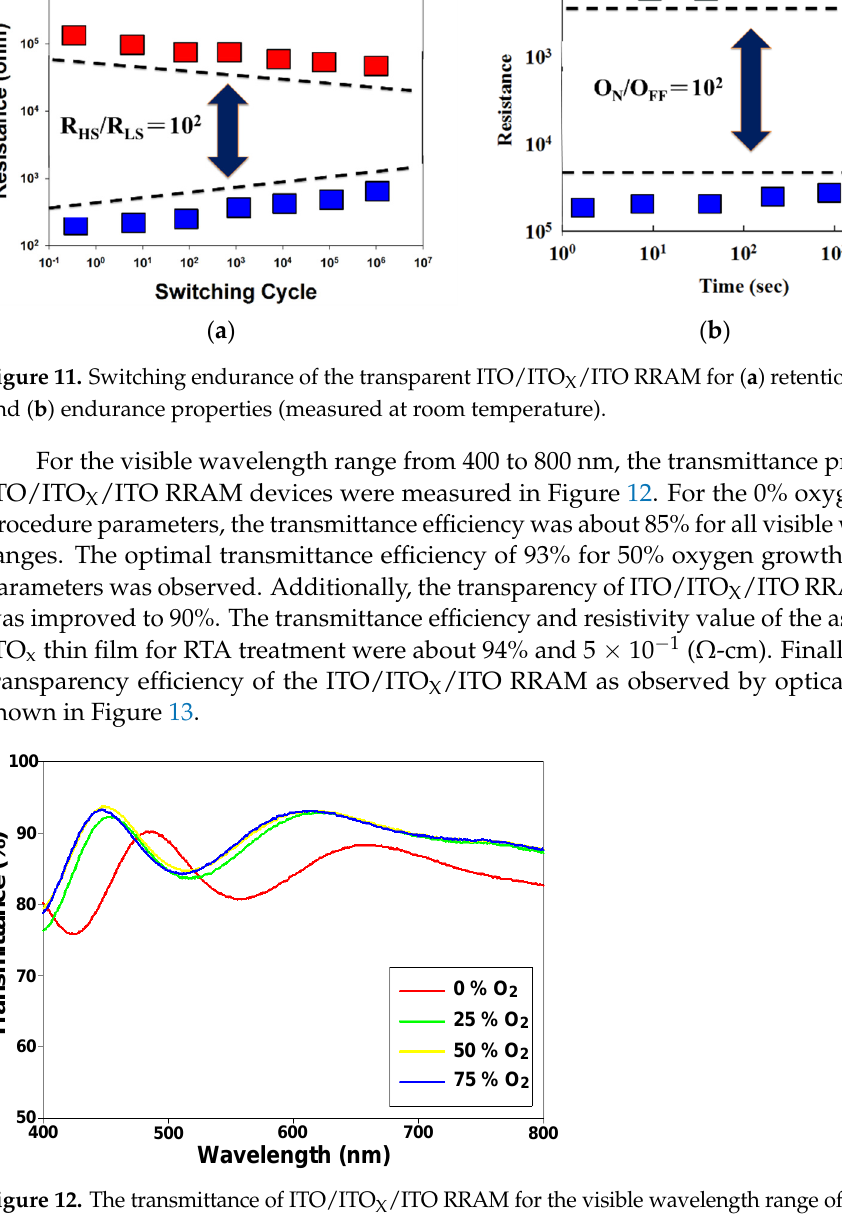
Bottom Electrode Figure 13. Optical images of the transparent ITO/ITO X /ITO RRAM device.